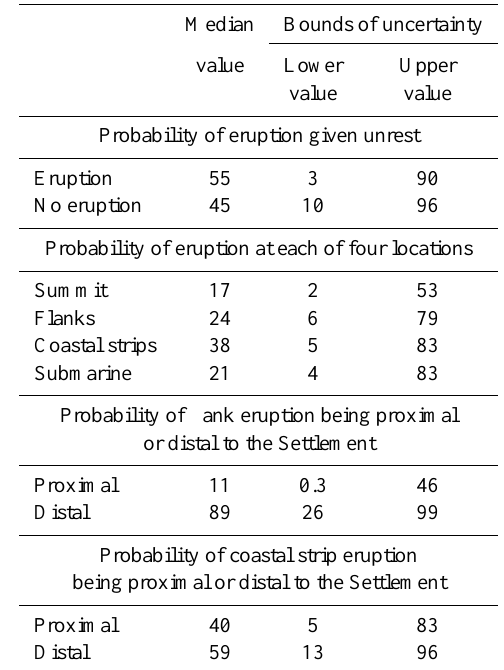
Table 1. Results from expert elicitation “event tree” exercise, con- ducted with 18 UK-based volcanologists. Median values for the group distribution are presented alongside the upper and lower bounds of the group